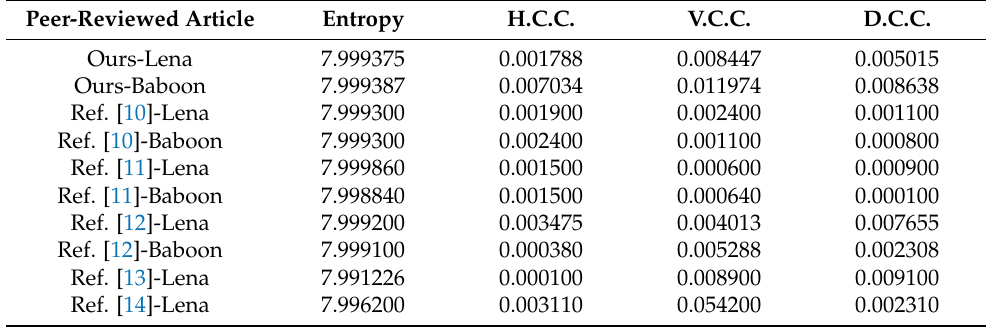
Table 13. Performance comparison between proposed scheme and others recently proposed.